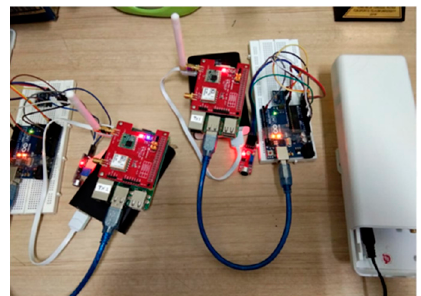
Figure 9. Prototype of the Proposed System.